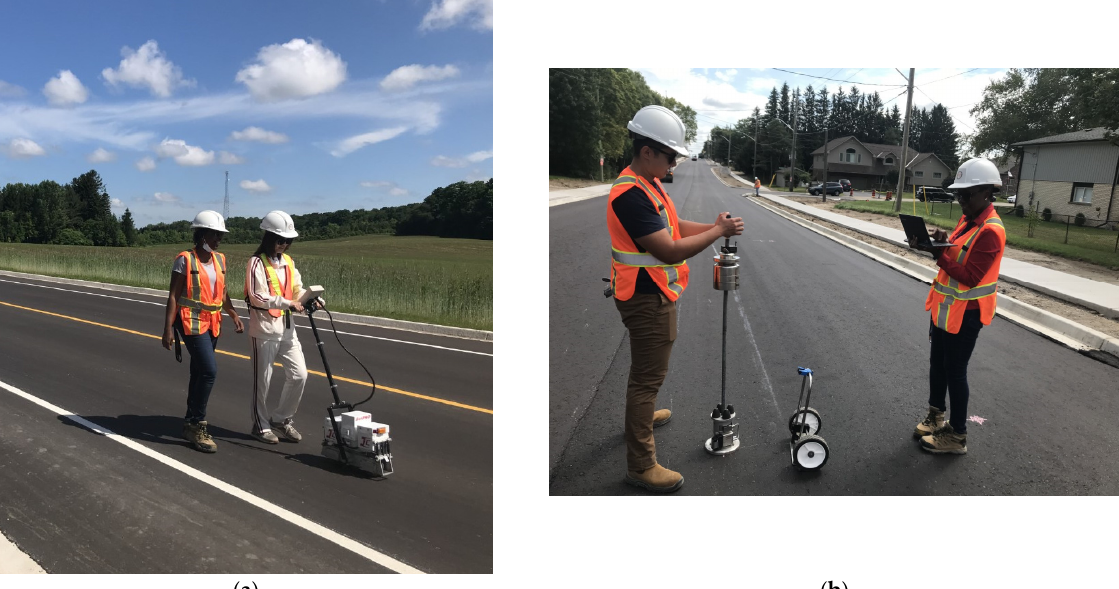
Figure 5. Testing equipment during testing at Notre Dame Drive ( a ) lightweight deflectometer ( b ) SurPro.